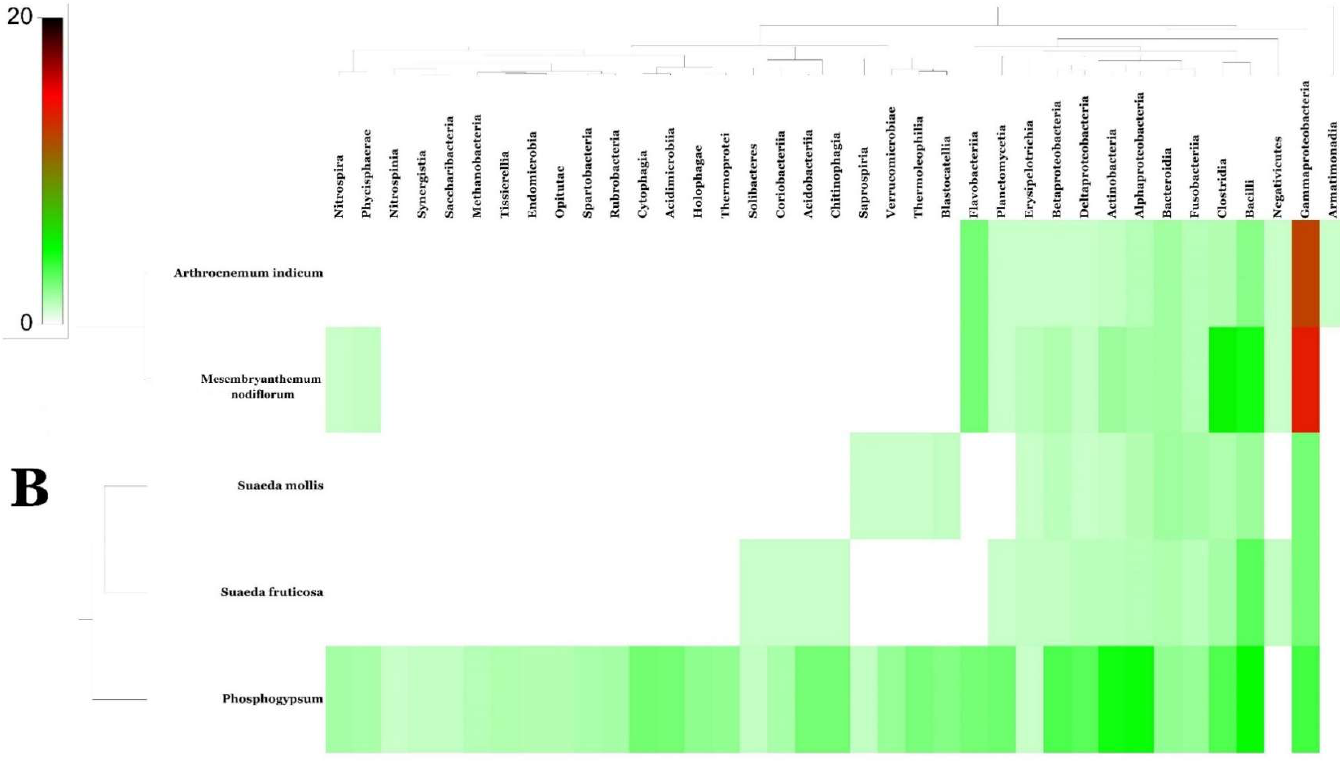
Figure 4. Bacterial community heat map of PG and plant microbiomes generated using SEED2 in phylum ( A ) order ( B ) and class ( C ) levels, respectively. 185